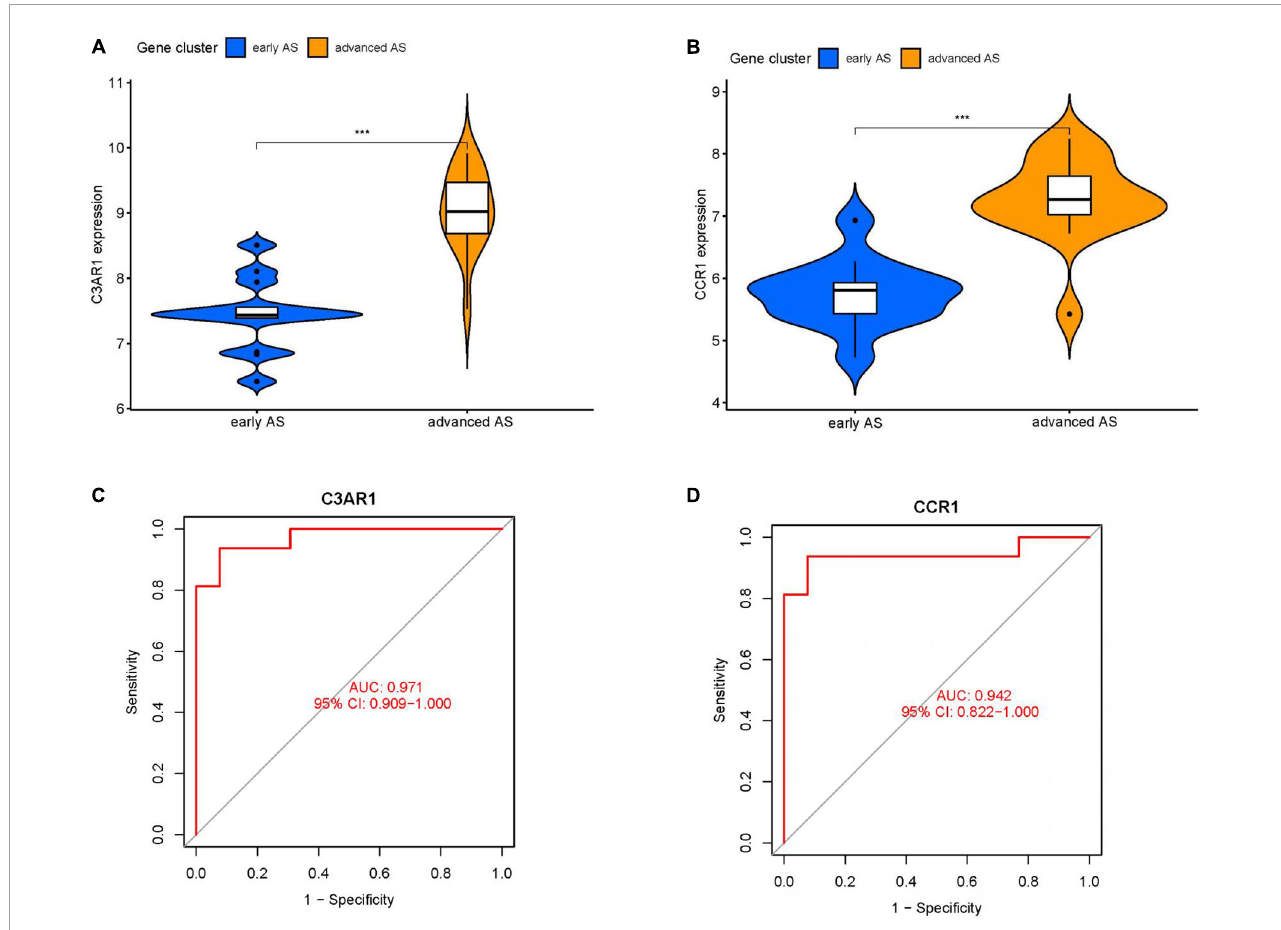
FIGURE6 Key gene analysis. (A) Violin plot of expression difference of C3AR1 in early and advanced AS. (B) Violin plot of expression difference of CCR1 in early and advanced AS. (C) ROC curve of C3AR1 distinguishing early and advanced AS. (D) ROC curve of CCR1 distinguishing early and advanced AS. (** P < 0.01, *** P < 0.001).